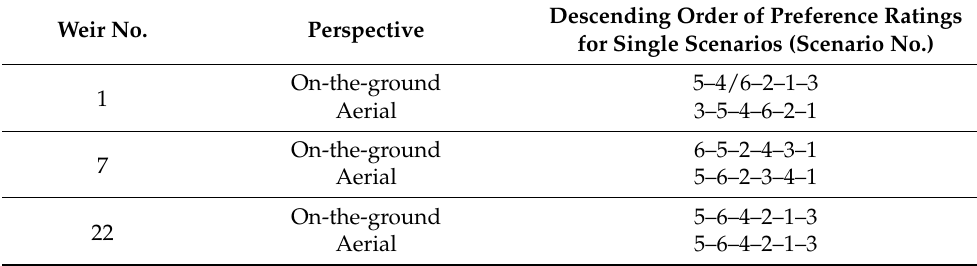
Table 4. Order of mean values of the preference ratings for the single sites. The numbered scenarios in the final column correspond to those given in Table 1. Descending Order of Preference Ratings Weir No. Perspective for Single Scenarios (Scenario